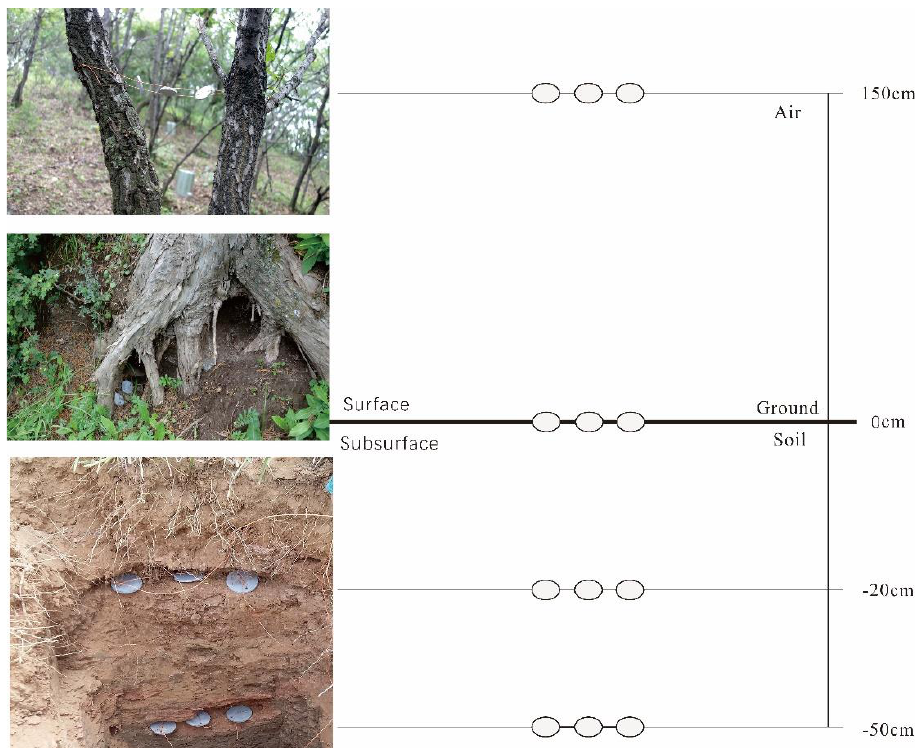
Figure 3. A picture and schematic diagram of the placement of tablets. The blue ellipse represents the test tablets. Three parallel specimens are normally placed in the same layer, and multiple sets are put in different layers. The dotted line indicates the tablets that are set perpendicular. The solid line is the string that threaded the tablets together. Reprinted with permission from Ref. [100], Copyright 2020